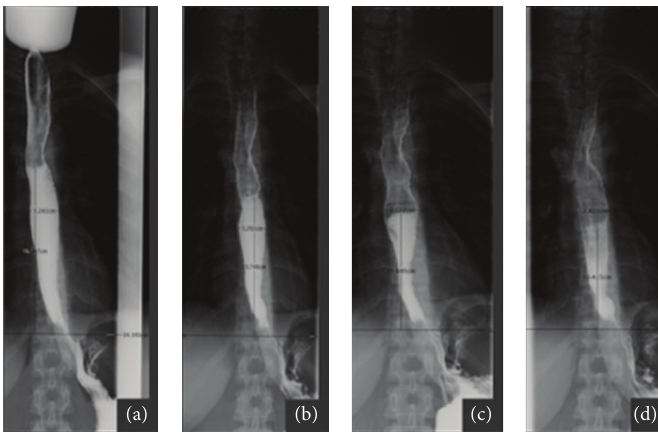
Figure 1: X-rays show the height of barium column 0, 1, 2, and 5 minutes after barium oral